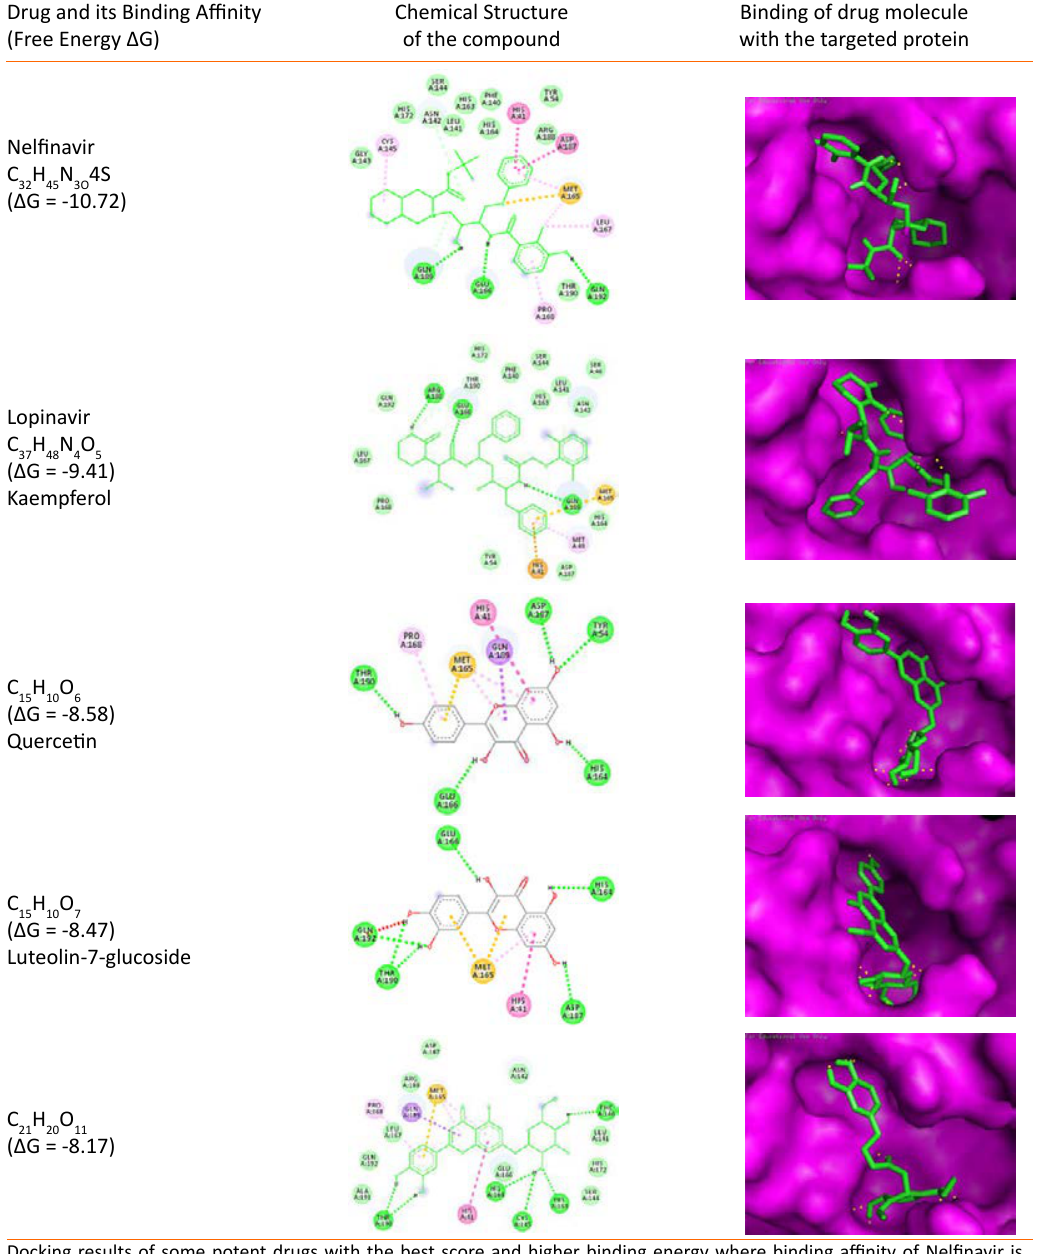
Table 1. Comparative analysis of potent drug compounds and their binding free energy (ΔG) with targeted protein Drug and its Binding